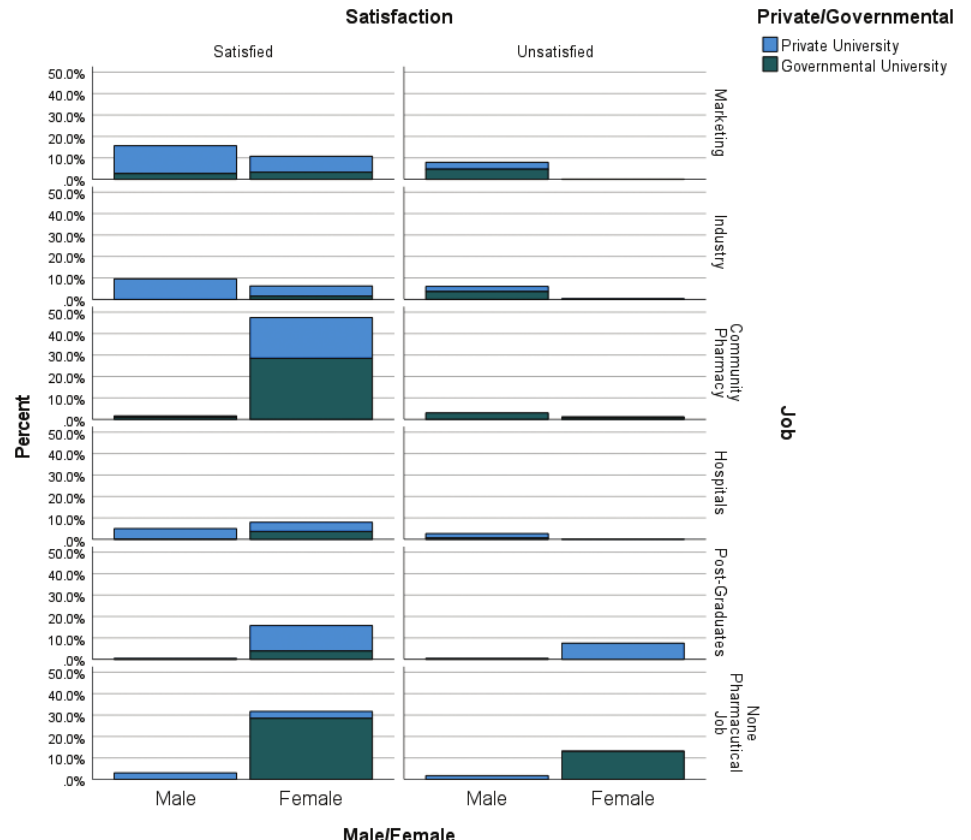
Figure 1. Correlation between Private and Governmental universities with job field and Graduates